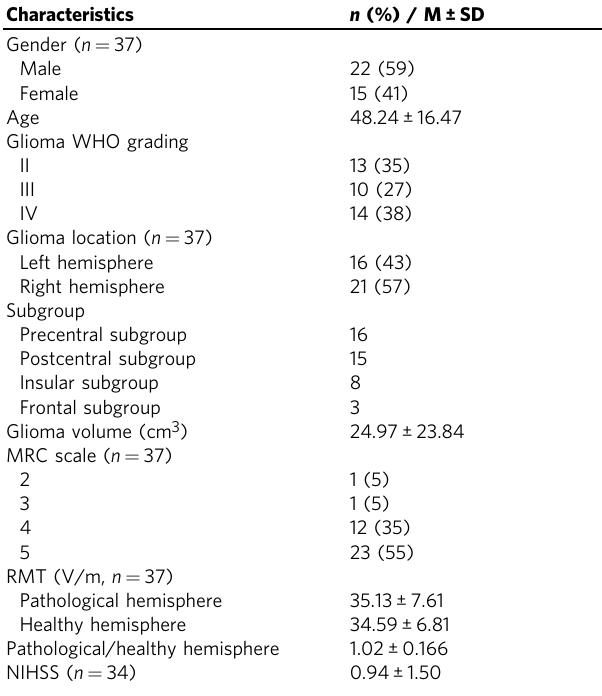
Table 1 Demographic data and clinical